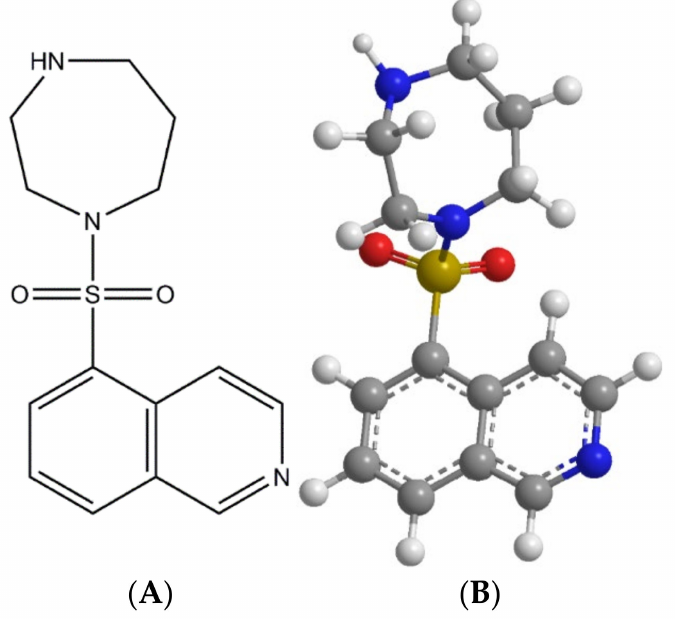
Figure 1. Structures of Fasudil (ChemDraw ® Ultra Ver. 10.0.; CambridgeSoft, Cambridge, MA, USA): ( A ). Chemical structure; and ( B ). ball-n-stick 3-D